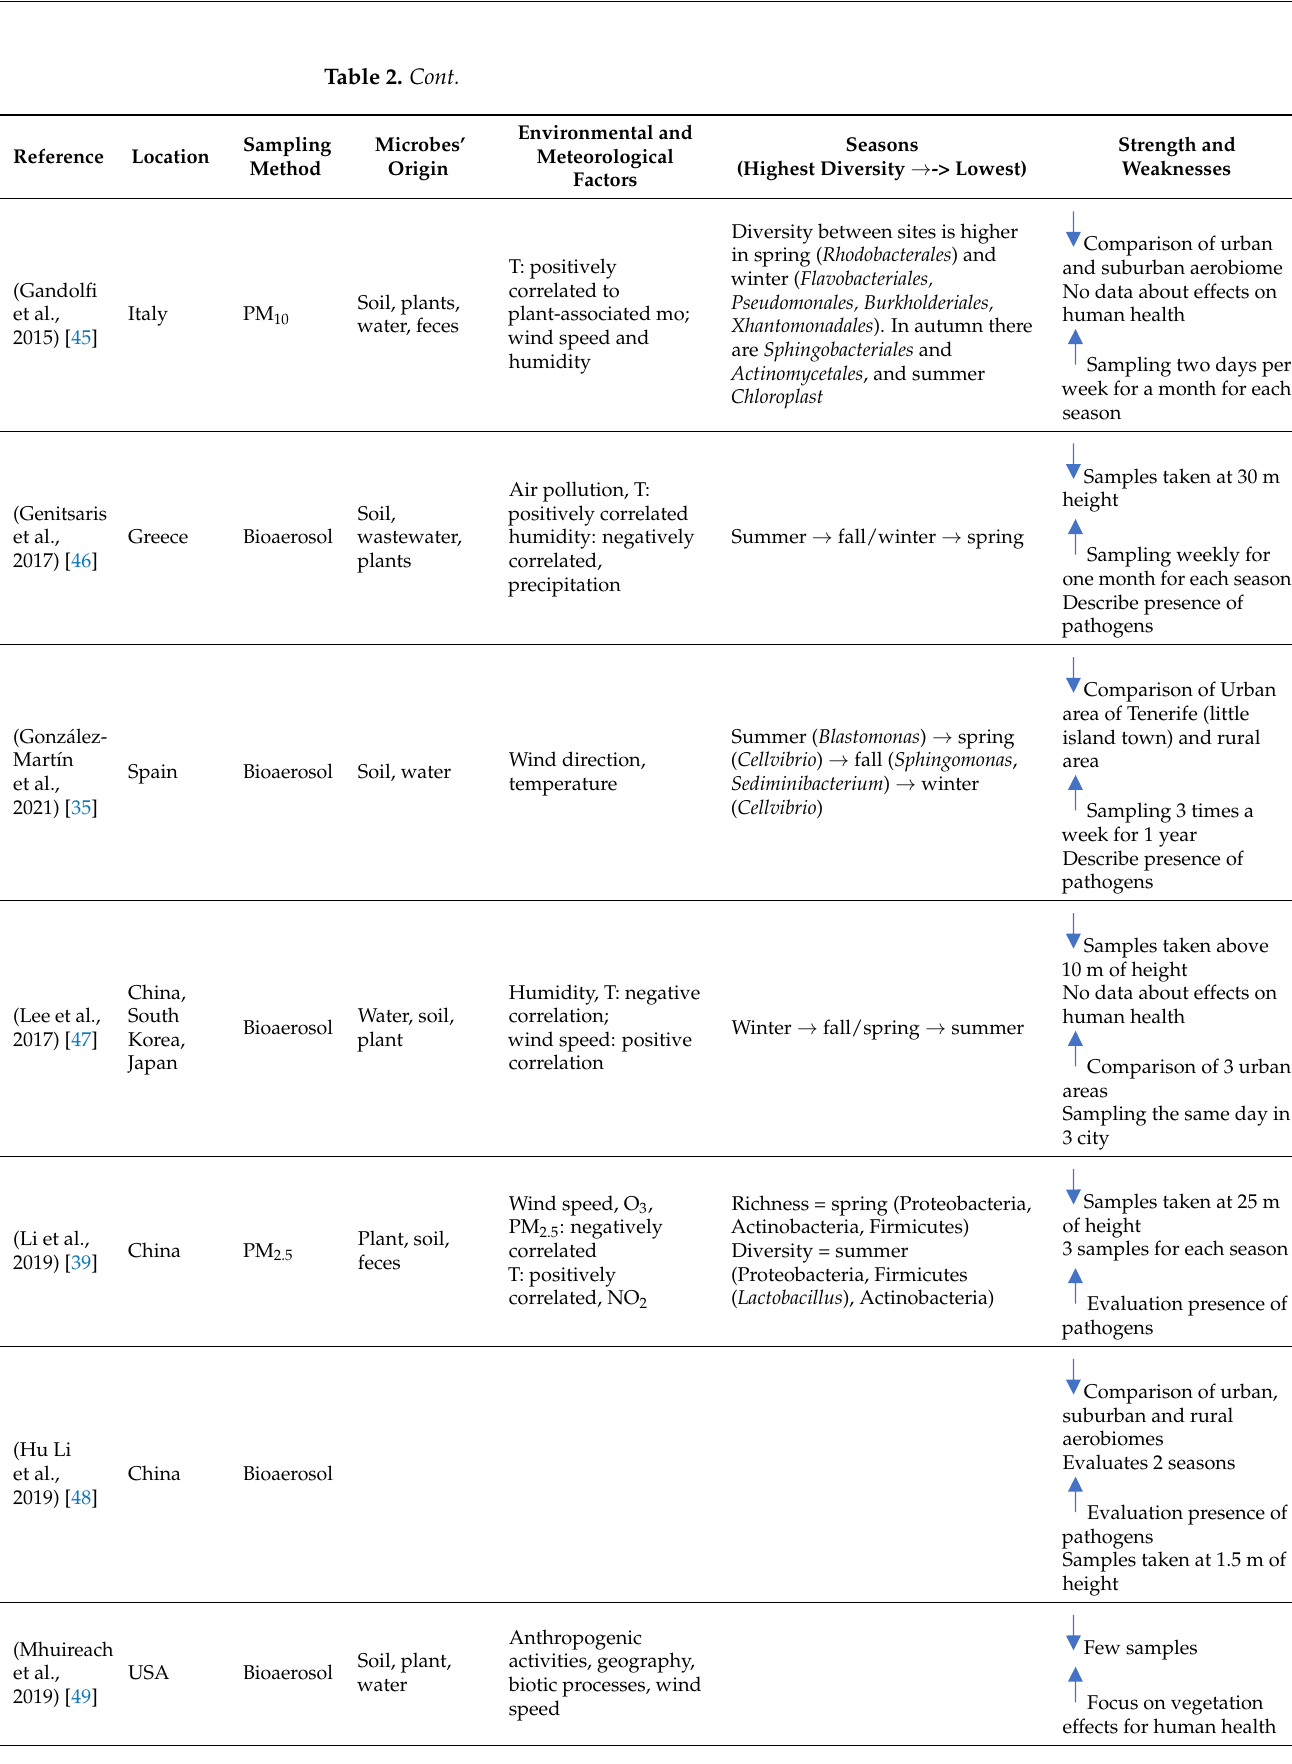
Table 2. Parameters that affect the microbial community: microorganisms’ emission sources, environmental and meteorological factors, and the season in which the alpha diversity was higher reported by each selected paper. Strength (indicated with ) and criticalities ( ) for each paper are